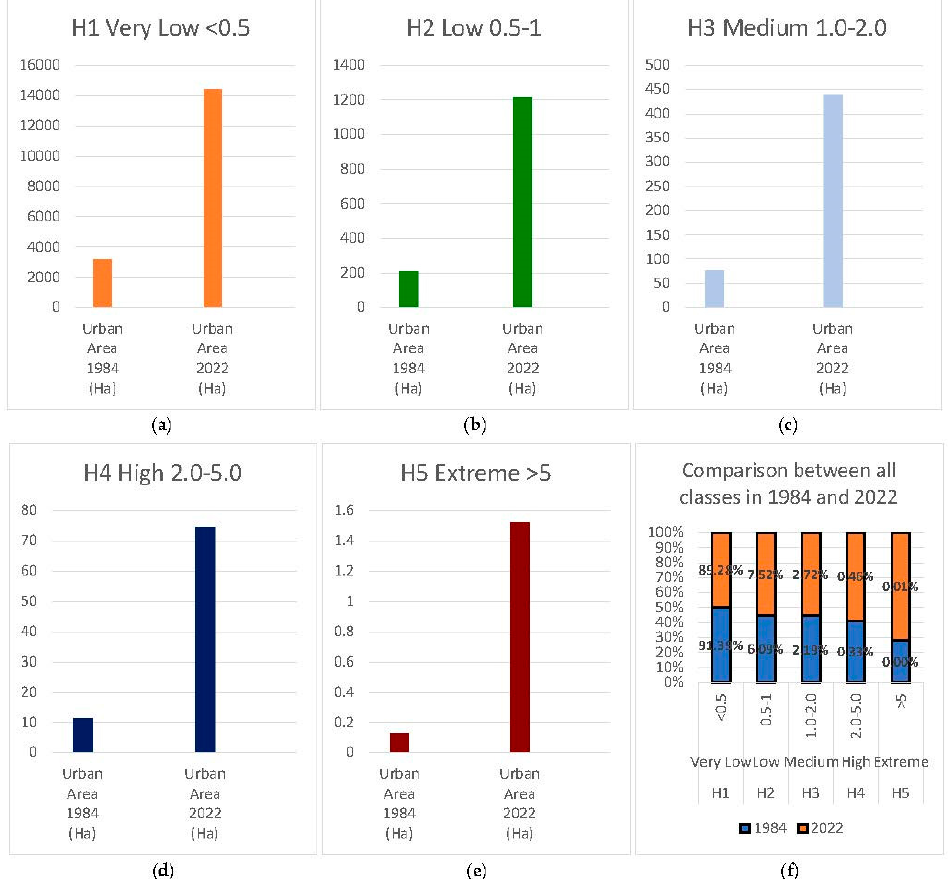
Figure 16. Urban areas exposure overall hazard classes 1984 and 2022.